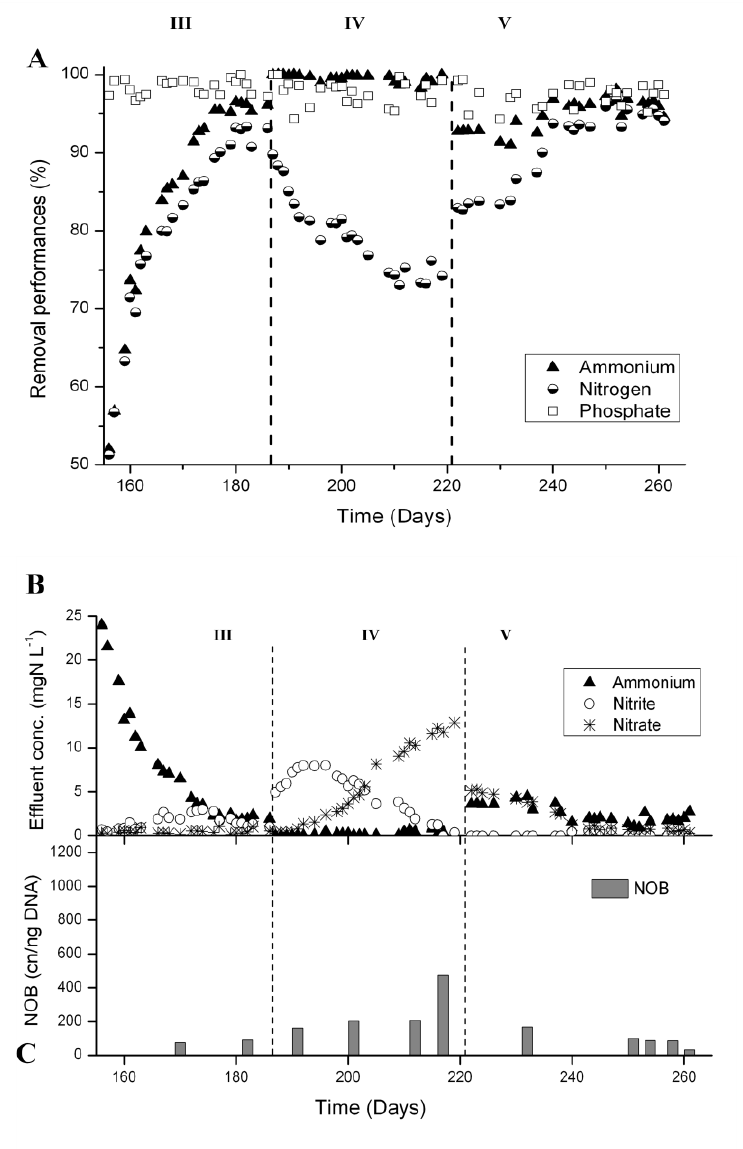
Figure 6. Nutrient removal performances at 20 °C (reactor A) from days 156 to